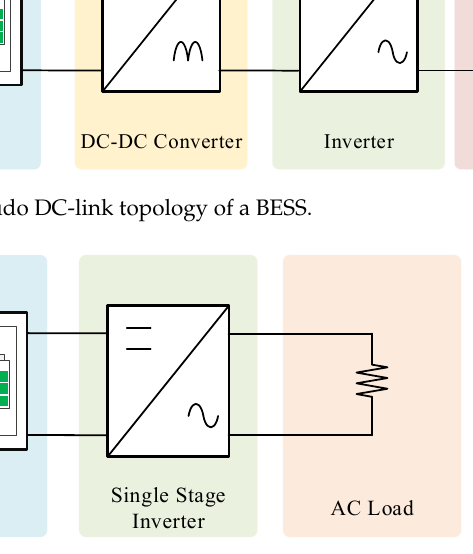
Figure 4. The single-stage topology of a BESS.